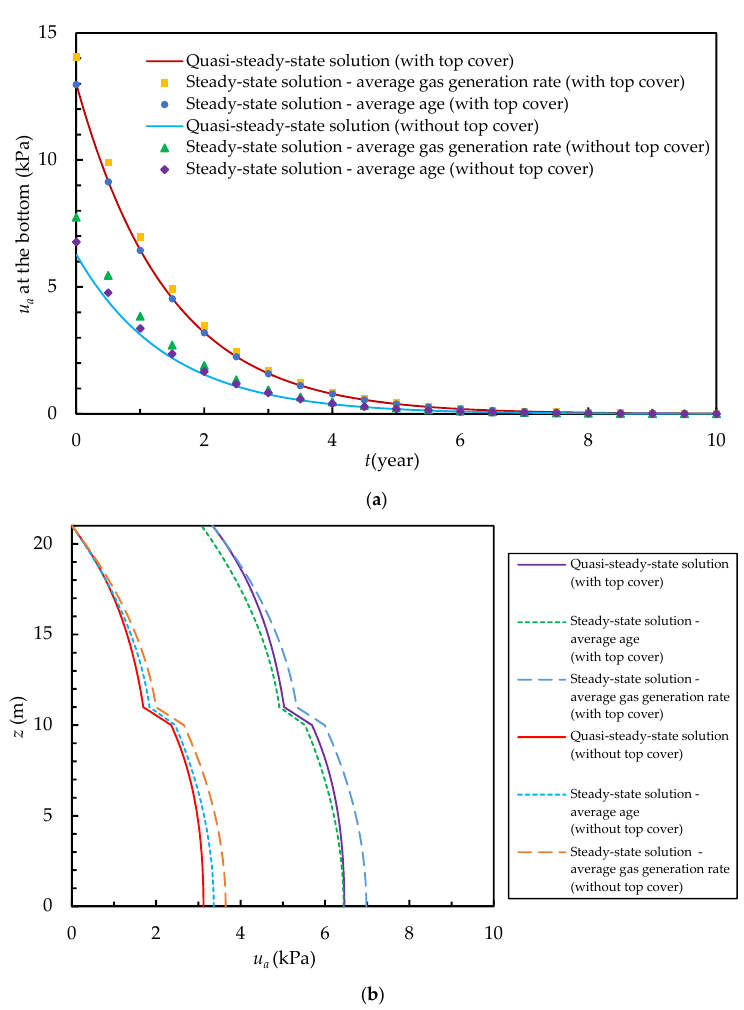
Figure 6. Changes of the gas pressure with time, calculated by the quasi-steady-state analytical solution and the steady-state analytical solution. ( a ) Gas pressure changing with time. ( b ) Gas pressure changing with depth at t = 1 year.